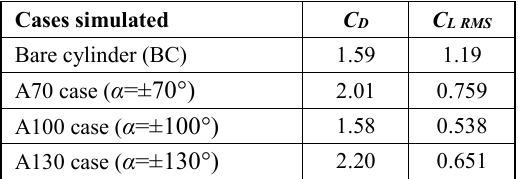
Table 2. Predicted time-averaged and rms force coefficients for cylinders with and without guiding